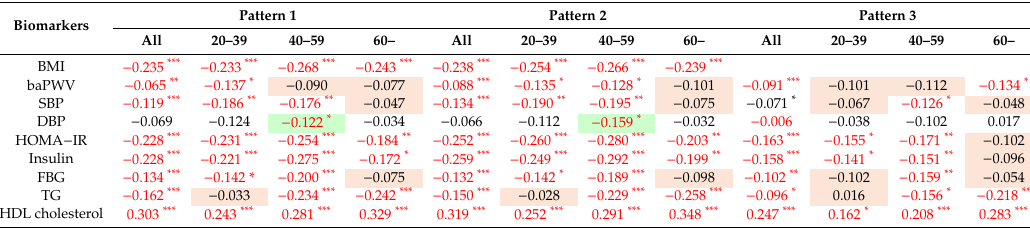
Yellow background color: relationship become non-significant by stratifying by age categories. Green background color: relationship become significant by stratifying by age categories. * p < 0.05, ** p < 0.01, *** p < 0.001. Significant values are shown in red. Pattern 1: calculated using multiple linear regression analysis after adjusting for age, antihypertensive drug use, and vitamins A, C, and E in the blood. Pattern 2: calculated using multiple linear regression analysis after adjusting for age, antihypertensive drug use, smoking habits, exercise habits, alcohol intake, and vitamins A, C, and E in the blood. Pattern 3: calculated using multiple linear regression analysis after adjusting for age, antihypertensive drug use, smoking habits, exercise habits, alcohol intake, BMI, and vitamins A, C, and E in the blood. BMI, body mass index; baPWV, brachial ankle pulse wave velocity; SBP, systolic blood pressure;